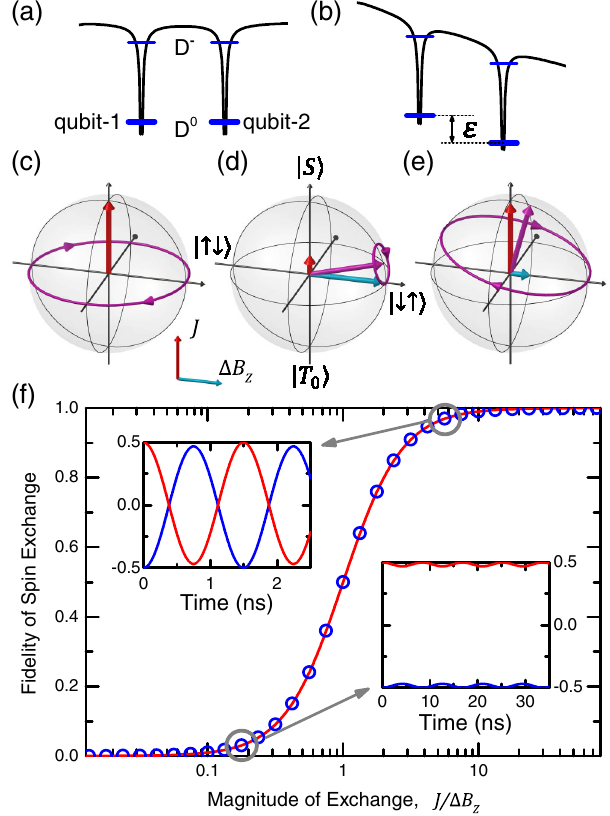
FIG. 1. (a),(b) Schematic of the conduction band profile of the coupled donor pair with qubit-1 and qubit-2 (a) in resonance and (b) detuned by ε . (c)-(e) Precession on the S − T 0 Bloch spheres with initial state j ↓↑ i for exchange-coupled electrons (c) in the absence of coupling to nuclei, (d) where J < Δ B (e) where J > Δ B . (f) Maximum fidelity of spin-state exchange z between the two donor electrons as a function of J normalized to Δ B . The insets show the time evolution of the expectation z value of the electrons initialized as j ↓↑ i for two values of J , illustrating the ability to control the amplitude of exchange